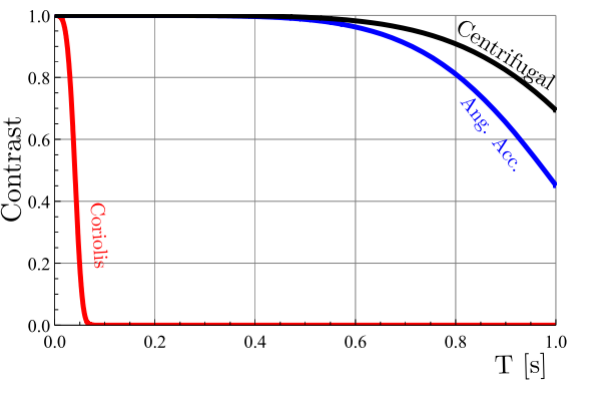
Figure 26. ( a ) Dependence of the acceleration sensitivity according to the interrogation time T . The dashed red line shows the sensitivity decrease, scaling as 1/ T 2 . ( b ) Dependence of the number of detected atoms according to the interrogation time T .